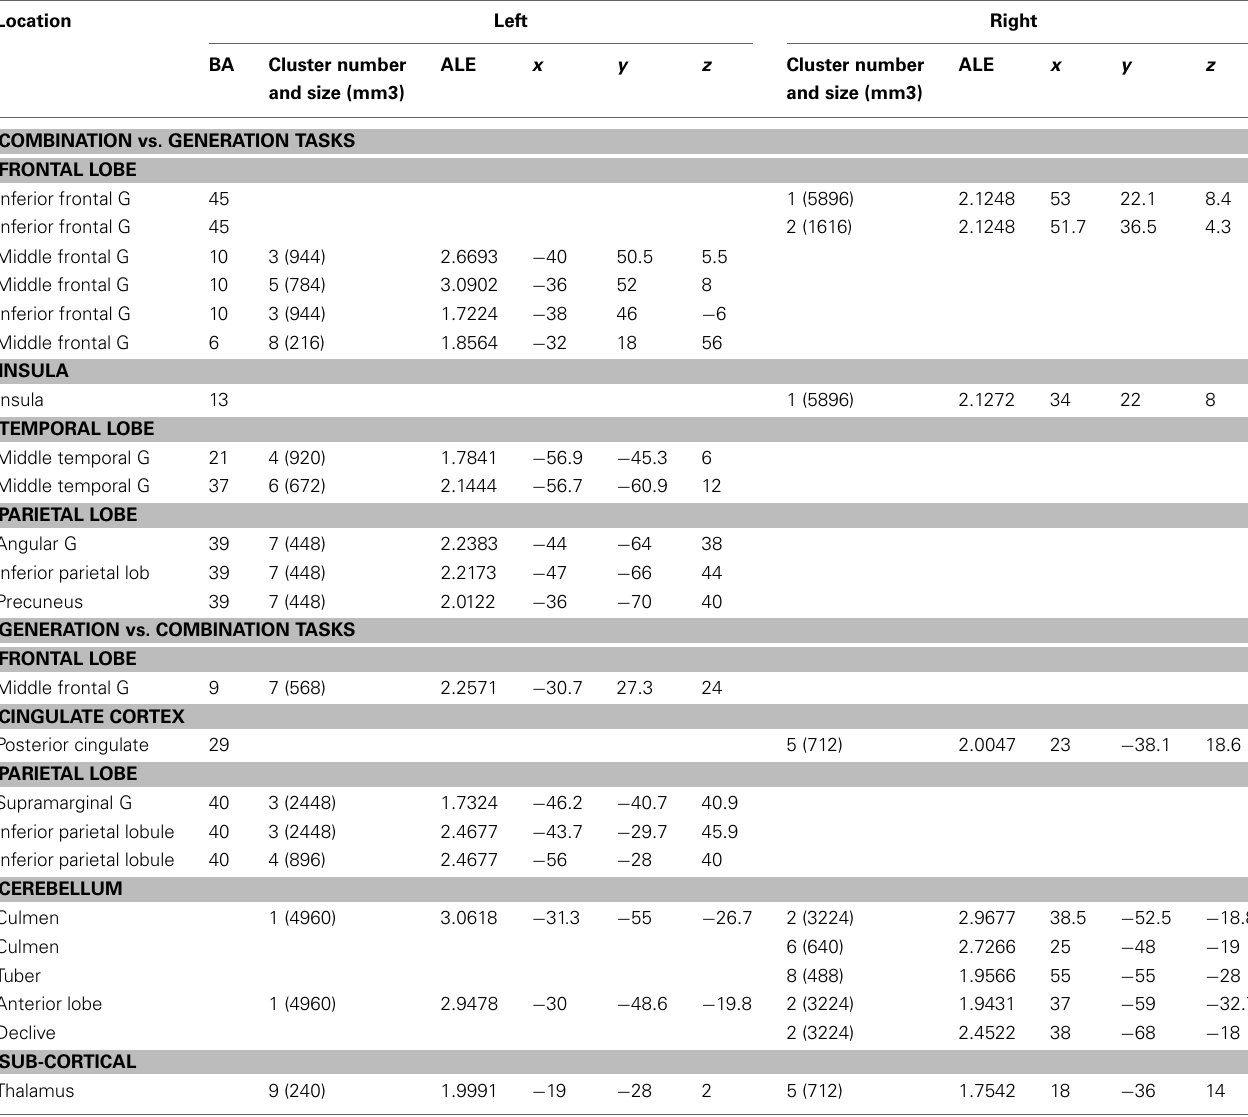
Columns number 3–7 represent data associated with the left hemisphere and 7–12 represent data associated with the right hemisphere. Abbreviations: BA, approximate Brodmann area; ALE, activation likelihood estimation; x, y, z coordinates, peak voxel in the Montreal Neurologic Institute (MNI)